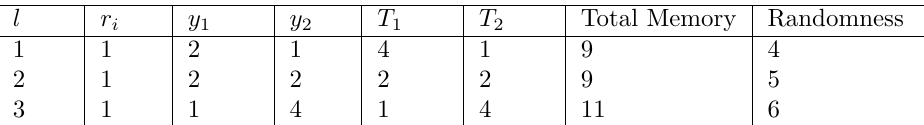
Table 4: Estimate of RAM memory required for Algorithm 6 for a (4,4)-bit S-box. Memory requirement (approximated in no. of bytes) for r i ’s, y 1 ’s, y 2 ’s, T 1 , T 2 , are also listed separately. The last column corresponds to the total number of random bytes required for r i , y 1 and y 2